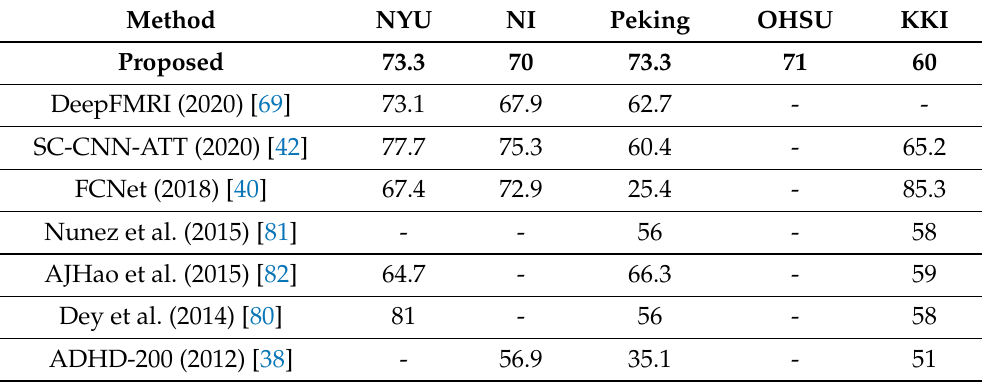
Table 6. Comparison of proposed method with state-of-the-art techniques.